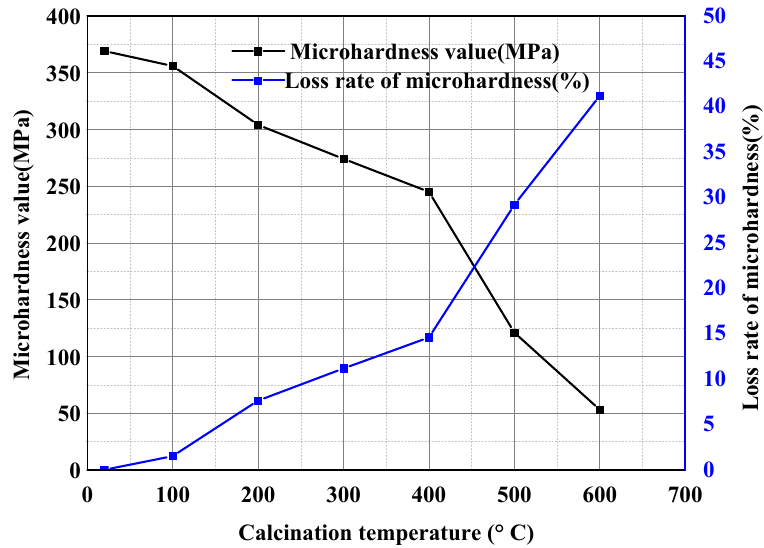
Figure 10. The microhardness and loss rate of natural aggregates at different calcination tempera- tures.